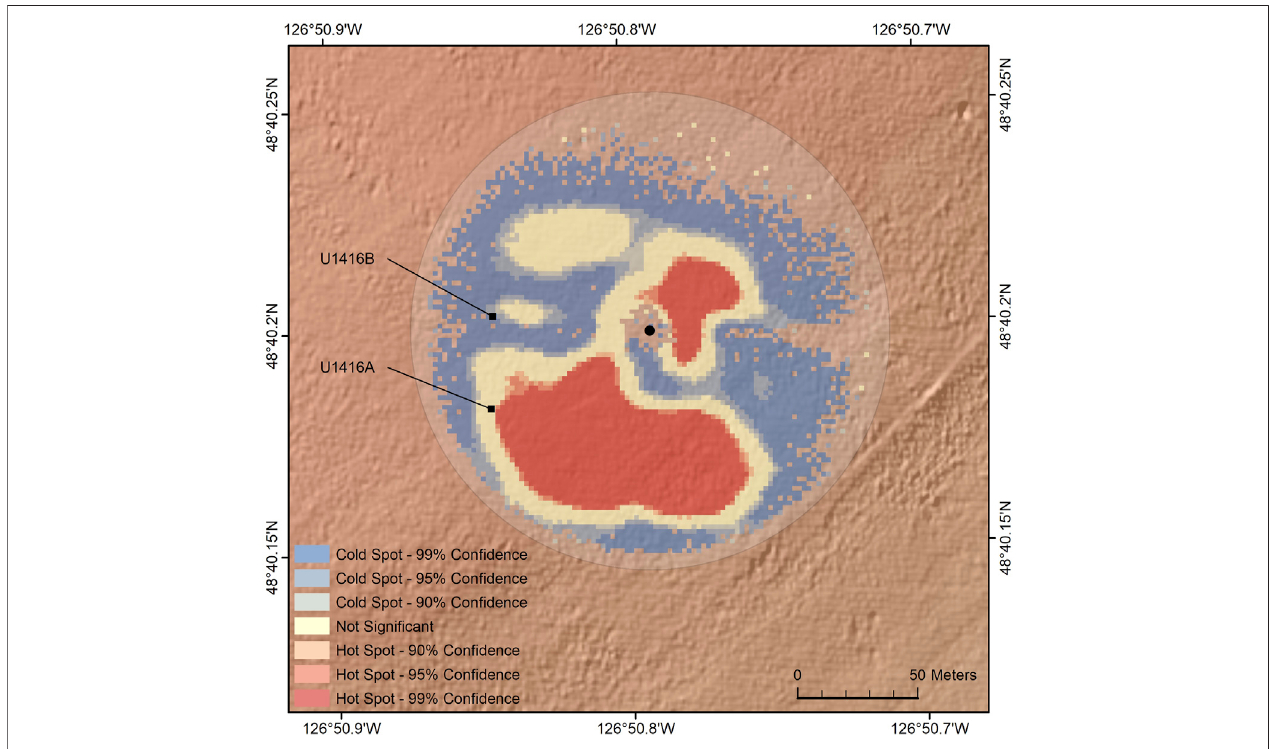
FIGURE 12 | Hotspot analysis of the fl are basepoints showing the areas where the gas emissions are the most likely to be observed. The fl are locations are not uniformly distributed and reveal at least two distinct areas where gas ebullition occurs. The central black dot represents the sonar location; the circle has a radius of 100 m and delineates the sonar monitoring area. The grey shaded area within the monitoring area represents zero-likelihood of gas source. The black squares are the locations of the IODP boreholes.